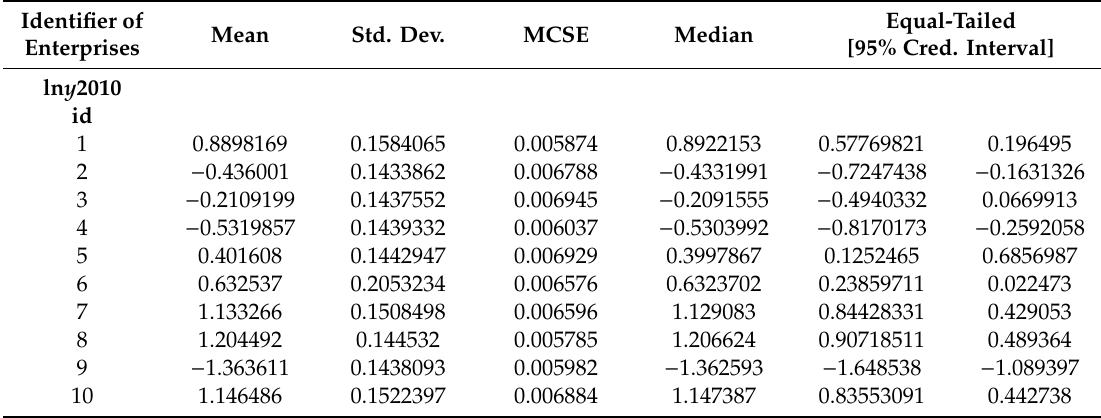
Table 4. Estimated random e ff ects of the first 10